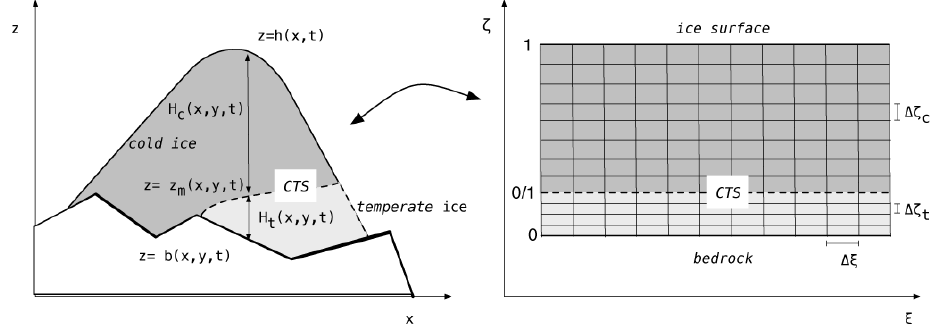
Figure 2. Terrain-following sigma transformation in the polythermal ice sheet. If temperate ice is present it is always below the cold ice. Hence, there are two separate sigma-transformed regular grids above each other, and they share their horizontal coordinate x → ξ and y → η (not shown here). The grid spacing 1ζ c and 1ζ t for cold and temperate are usually different and also the sigma-transformation is different for both domains (see Greve, 1997a). CTS denotes the cold–temperate